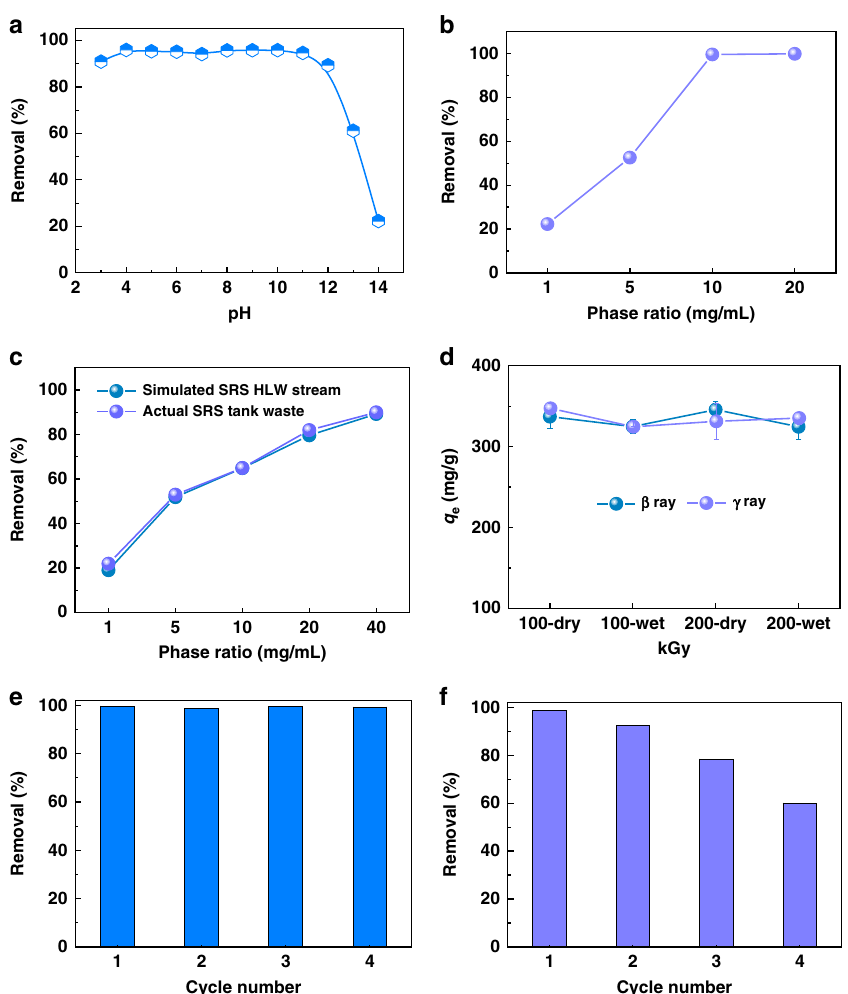
Fig. 4 Hydrolytic stability, radiation resistance, and reusability of SCU-103. a Effect of pH on the removal of ReO 4 − by SCU-103 (initial concentration of Re: ~200 ppm; solid – liquid ratio of 1 mg/mL). b Removal of ReO 4 − by SCU-103 with various solid – liquid ratios in 1 M NaOH solution containing ~200 ppm of Re. c 99 TcO 4 − removal by SCU-103 with various solid – liquid ratios in simulated SRS HLW stream and actual SRS tank waste. d ReO 4 − sorption capacities of SCU-103 after different doses of β and γ radiation (initial concentration of Re: ~400ppm). Error bars represent S.D. n = 3 independent experiments. e Reusability of SCU-103 for removing ReO 4 − at pH 7 with initial concentration of Re ~28 ppm. f Reusability of SCU-103 for removing ReO 4 − in 1 M NaOH containing ~200 ppm of (Supplementary Table 8). Impressively, the removal ef fi ciencies in 1 M NaOH solution can increase to >99% at solid – liquid ratios of 10 mg/mL and above (Fig. 4b, (Supplementary Table 9). Such a 99